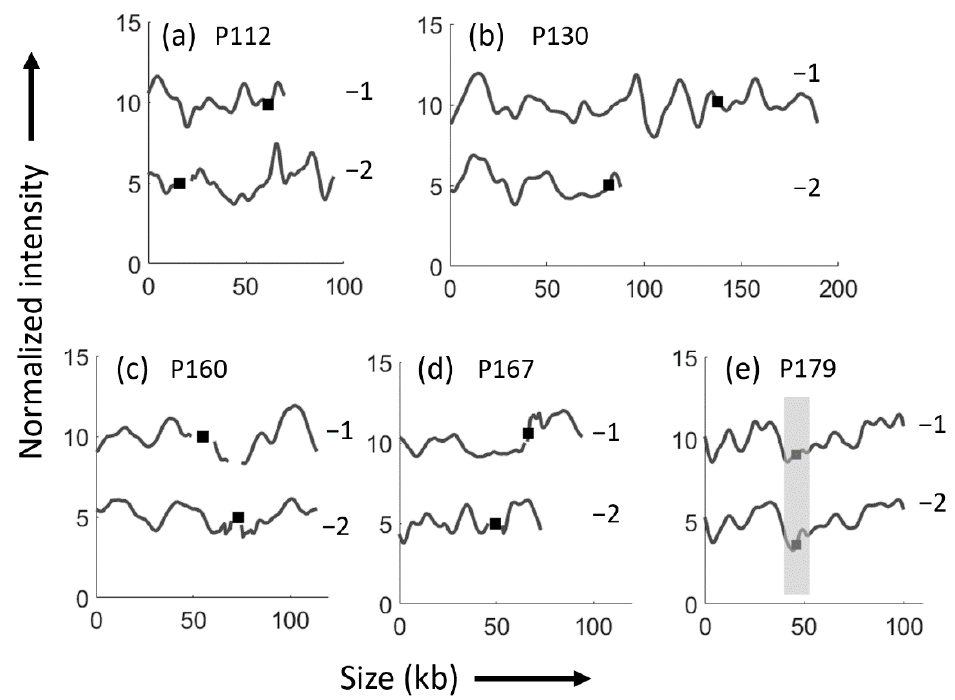
Figure 1. ODM results of ESBL E. coli isolates analyzed for bla CTX-M gene in patients with recurrent urinary tract infections caused by different ESBL E. coli strains. ( a ) Patient P112 with nonidentical bla CTX-M-27 encoding plasmids in P112-1 (70 kb), and P112-2 (86 kb). ( b ) Patient P130 with noniden- tical bla CTX-M-15 encoding plasmids in P130-1 (189 kb) and P130-2 (93 kb). ( c ) Patient P160 with nonidentical bla CTX-M-27 encoding plasmids in P160-1 (104 kb) and P160-2 (114 kb). ( d ) Patient P167 with nonidentical bla CTX-M-27 encoding plasmids in P167-1 (89 kb) and P167-2 (73 kb). ( e ) Patient P179 with identical bla CTX-M-27 encoding plasmids in P179-1 and P179-2 (100 kb). Black squares indicate the lo- cation of the gene and the region shaded in grey indicates that the gene is in the same location in figure e.